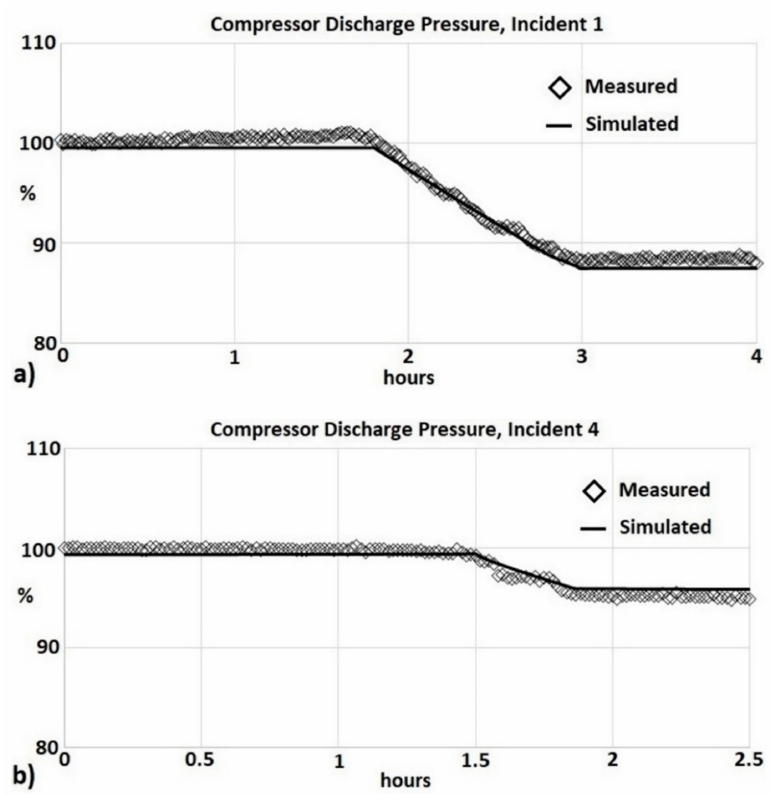
Figure 22. Measured and simulated compressor discharge pressures: ( a ) Incident 1; ( b ) Incident 4.